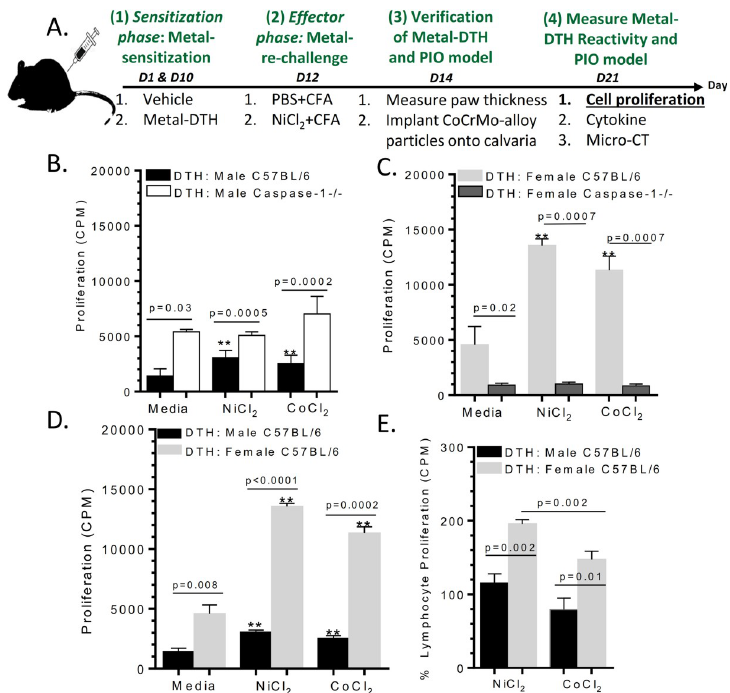
Fig 2. Female metal-sensitized (metal-DTH) BL/6 mice exhibit higher levels of lymphocyte proliferation reactivity. (A) Schematic model demonstrating experimental design. Lymphocytes were purified from mouse spleens at Day 21 and co-cultured with or without Ni or Co challenge for four days to measure amount of lymphocyte proliferation responses via LTT from either (B) male or (C) female metal-DTH BL/6 and Caspase-1 -/- mice, and cell proliferation was measured by 3 H-thymidine incorporation. (D) Comparison of lymphocyte metal sensitivity responses in male vs. female BL/6 mice, and (E) percentage increase of lymphocyte proliferation to metal challenge; calculated using cell proliferation to metal(s) vs. respective cell proliferation to media. Data represents two independent experiments with n = 4–5 mice/group in each experiment. Data are shown as the mean ± SEM. Statistical significance was determined by unpaired Mann-Whitney test and asterisk ( �� ) denote significant differences at p < 0.005 compared to respective in vitro media challenged cell group.